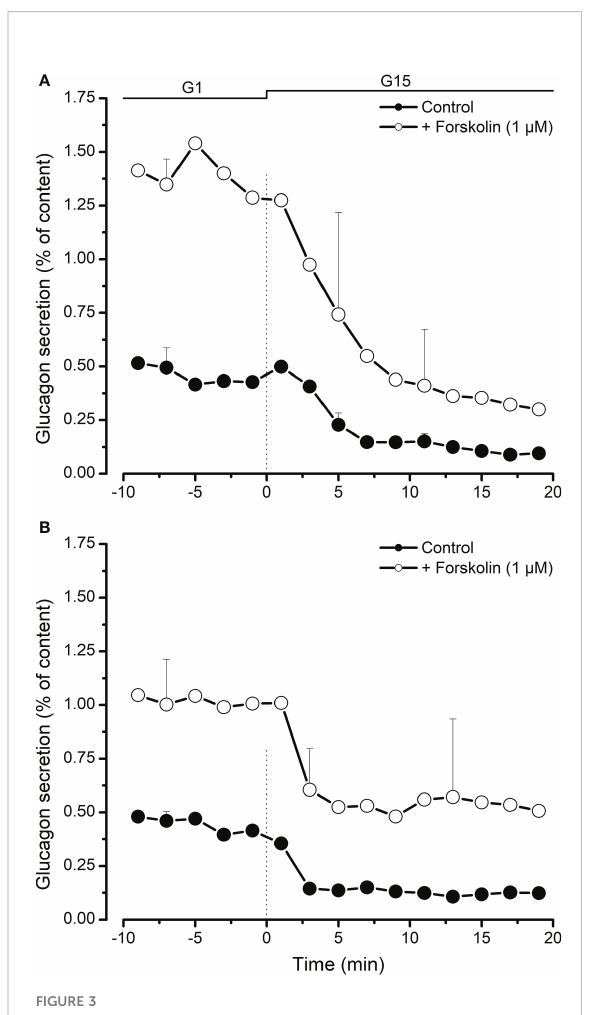
FIGURE 3 Inhibition of glucagon secretion by high glucose (15 mM, G15) from neonatal (A) and adult (B) porcine islets in the presence ( ○ ) or absence ( ● ) of forskolin (1 µM, adenylyl cyckase activator causing an increase of cytosolic cAMP). Values are means ± SEM from n=3 different preparations from each age group.